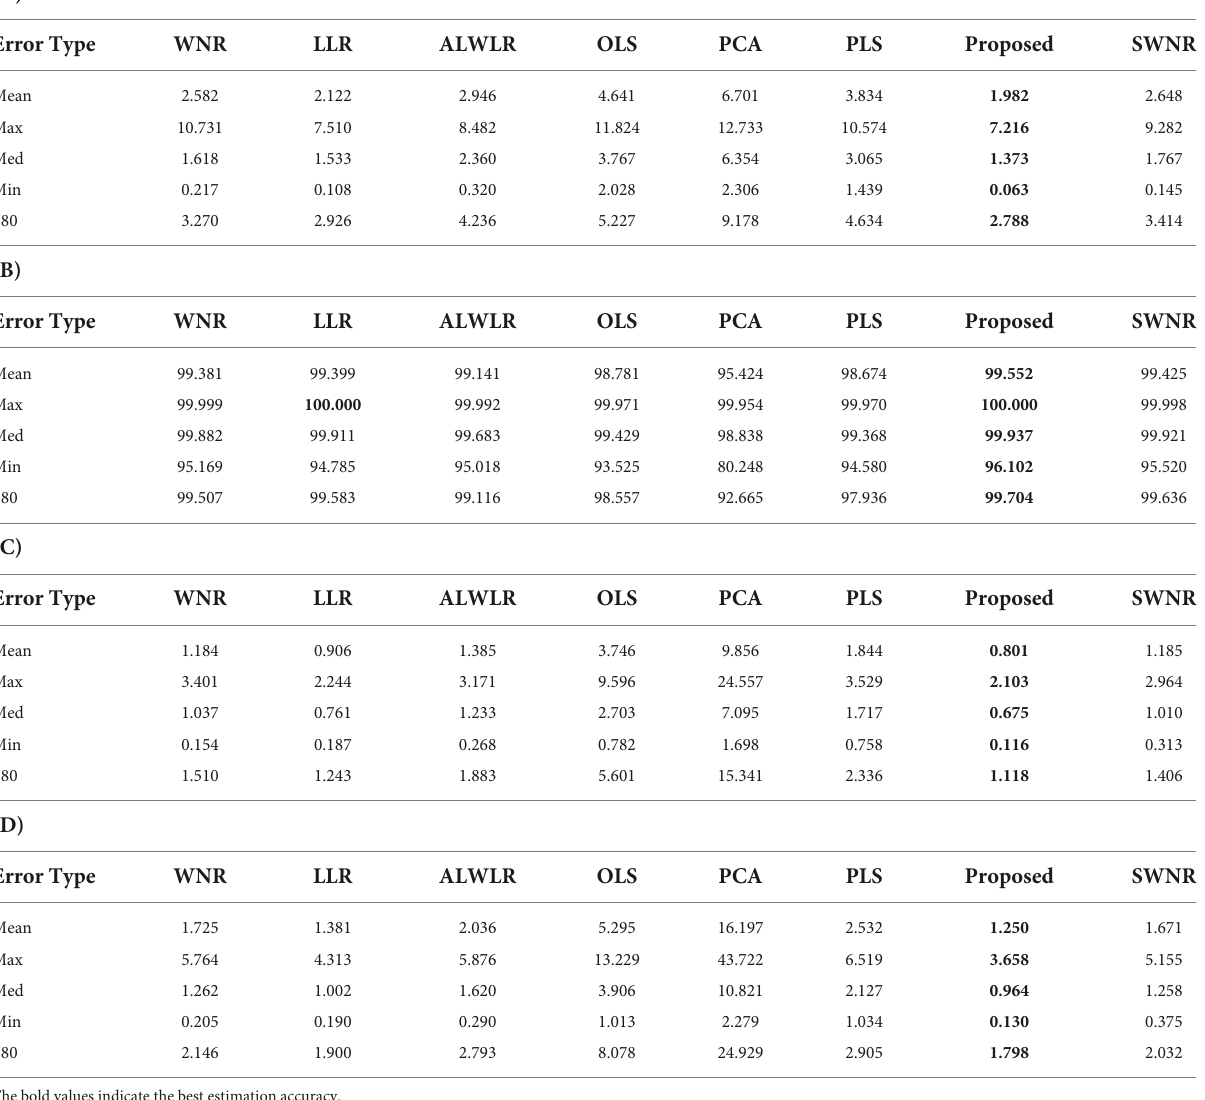
TABLE 5 Comparison of estimation accuracy between the proposed method and seven existing methods: (A) RMSE, (B) GFC, (C) (cid:49) E ∗ ab , and (D) (cid:49) E 00 .